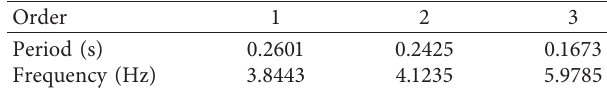
Table 2: Periods and frequencies of the first three